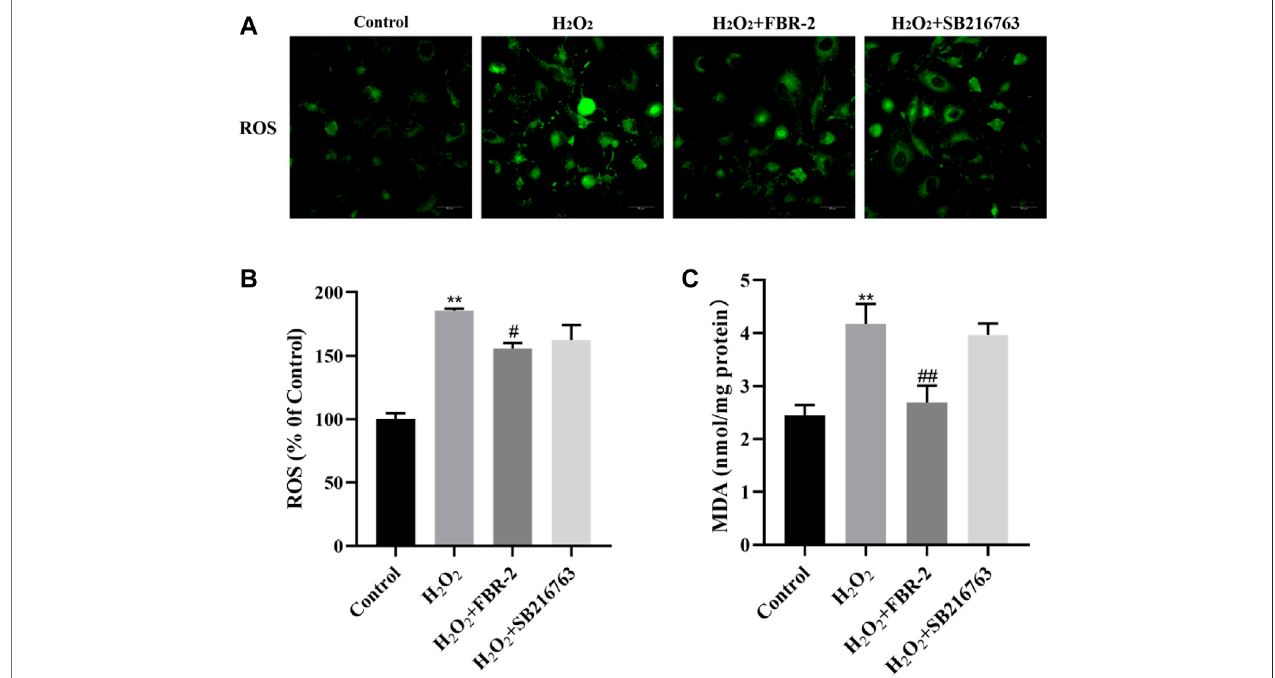
FIGURE 3 | FBR-2 inhibits the production of ROS and MDA in A549 cells induced by H 2 O 2 . (A) Fluorescence microscopy observation of ROS production in cells. (B) The level of ROS ( n = 5). (C) The level of MDA ( n = 6). ** p < 0.01, compared with the control group; # p < 0.05 and ## p < 0.01, compared with the H 2 O 2 group.